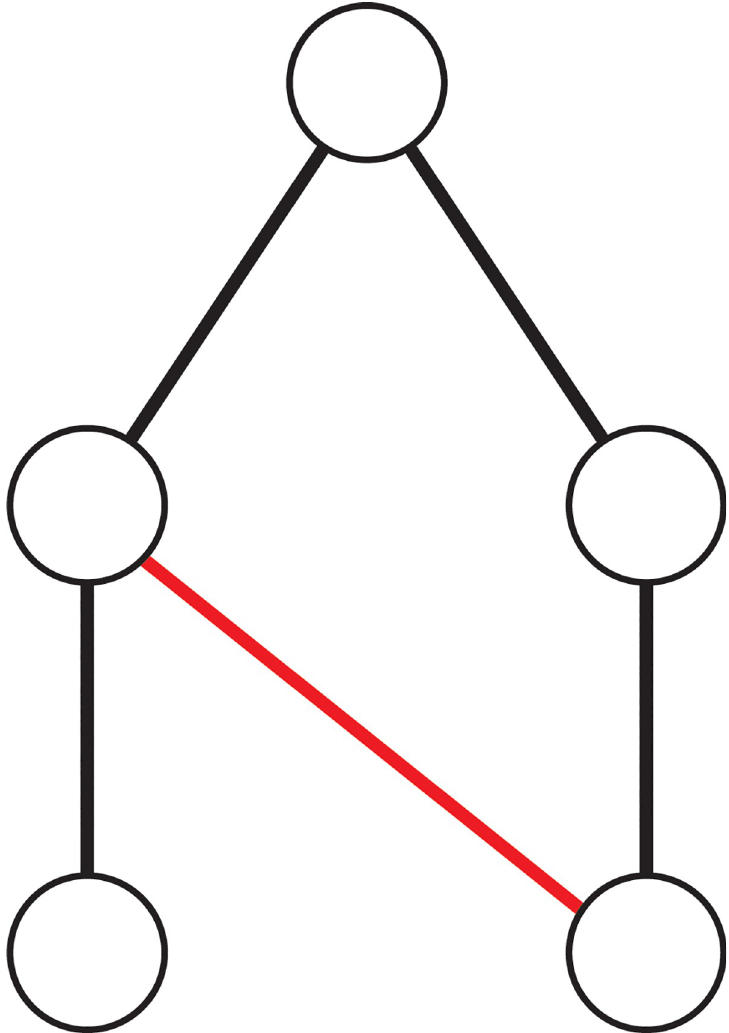
Fig 2. Simple closed loop showing the relationship where one examiner had the same intellectual "father" or "mother" as the supervisor of the student being examined. Black lines show supervisory relationships. Red lines show examiner